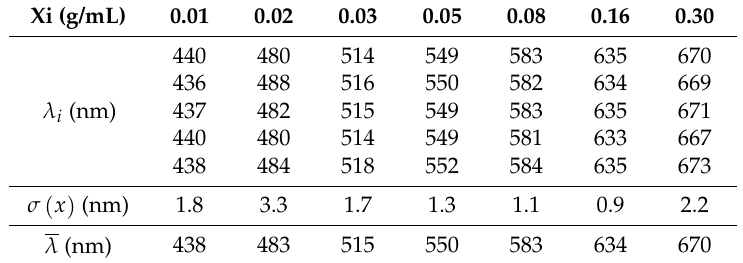
Table 4. Wavelengths of direct absorption measurements for each solid-liquid relation (Xi) value.